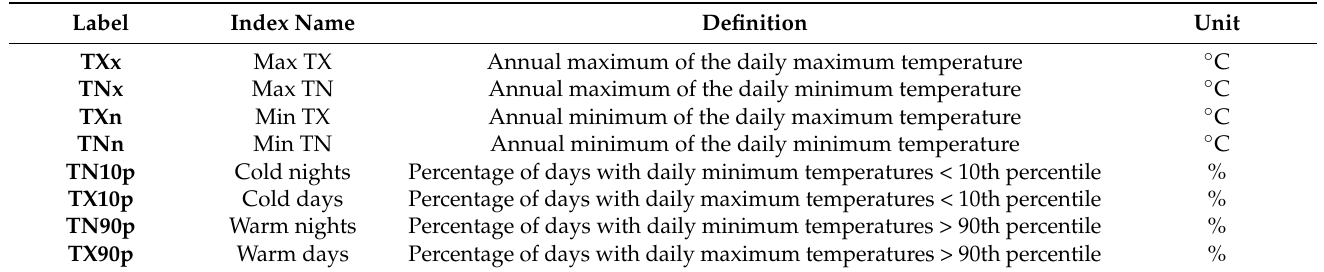
Table 1. Core set of the selected extreme temperature indices recommended by the